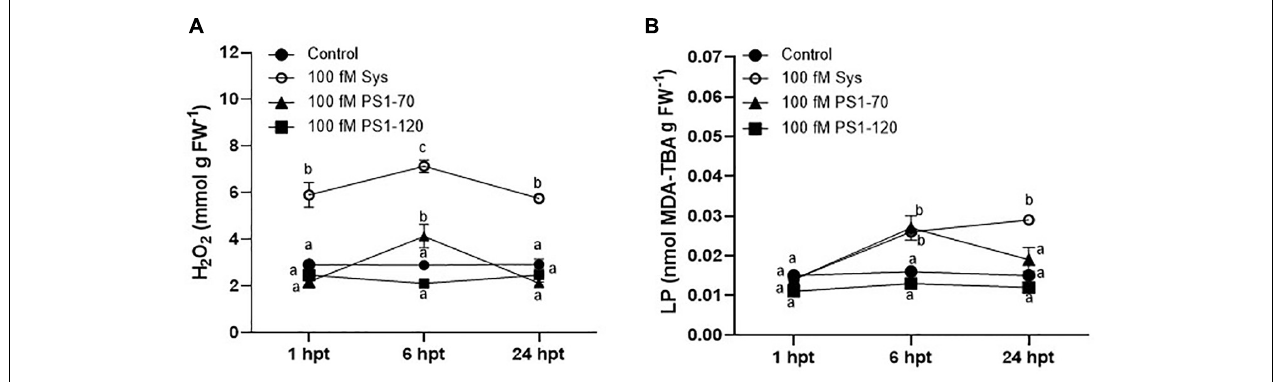
FIGURE 5 | H 2 O 2 and MDA content in tomato leaves treated with 100 fM ProSys fragments. H 2 O 2 . (A) and MDA, (B) contents were measured in control (PBS1X) and in treated leaves at 1, 6, and 24 hpt with 100 fM Sys, PS1-70 and PS1-120. Different letters indicate statistically significant differences (One-Way ANOVA, P < 0.05). Error bars indicate standard error.